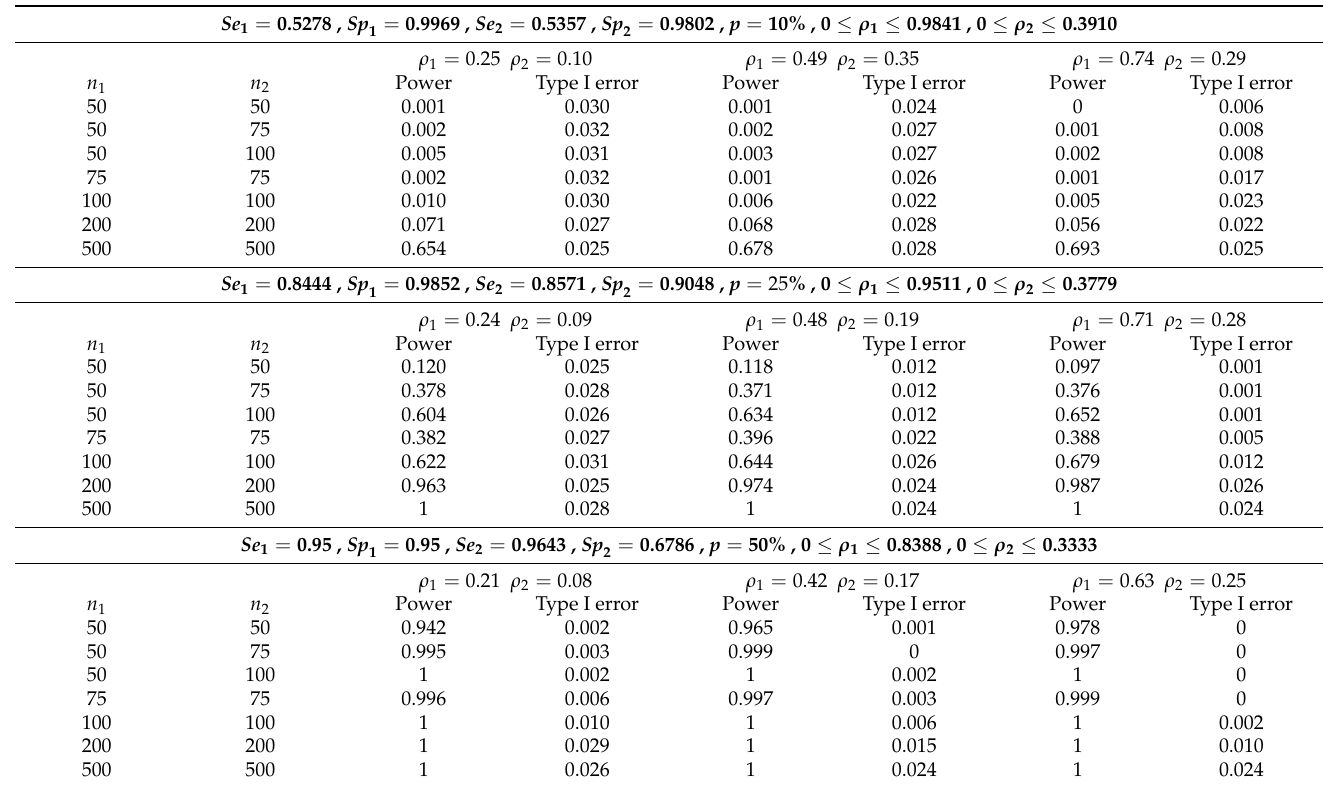
Table 7. Power of the test H 0 : PPV 1 = PPV 2 and type I error of the test H 0 : NPV 1 = NPV 2 PPV 1 = 0.95, NPV 1 = 0.95, PPV 2 = 0.75 and NPV 2 =